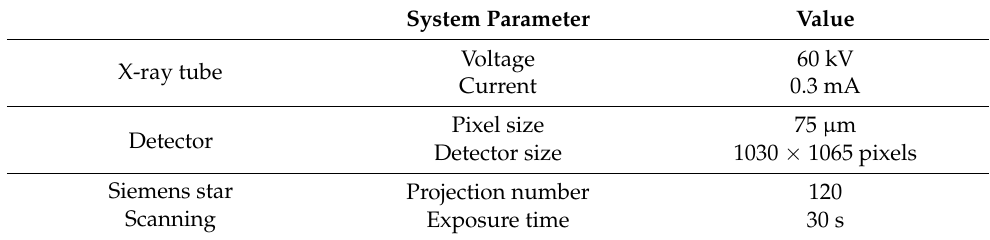
Table 1. The detailed parameters of nano-CT and scanning parameters of a Siemens